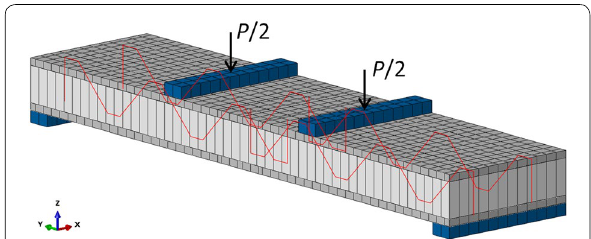
Fig. 16 Finite element model of the bending tests with single connector